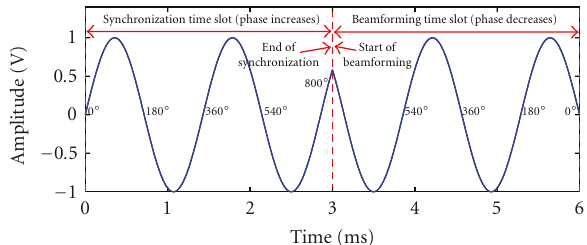
Figure 4: Output waveform of DDS in beamforming time slot is in reverse time sequence to that in synchronization time